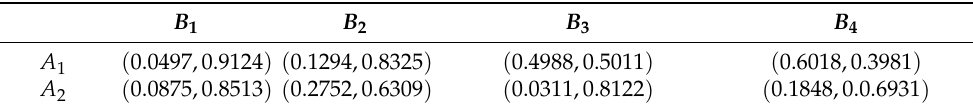
Table 5. Positive and negative ideal solutions for